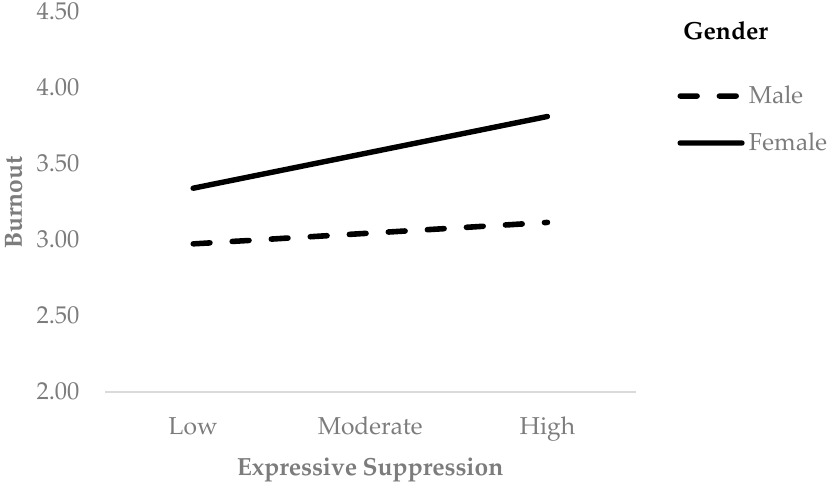
Figure 5. Maladaptive downregulation of positive emotions predicting burnout as a function of gender.